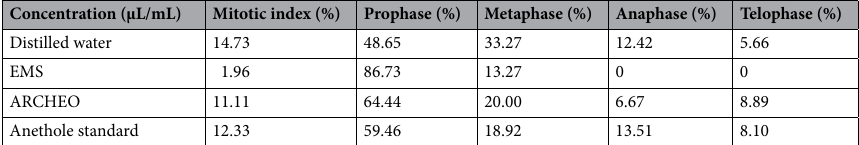
Table 7. Mitotic index and different stages of dividing cells in root tips of Allium cepa treated with ARCHEO , anethole (standard) and EMS. ARCHEO anethole rich C. heptaphylla essential oil, EMS ethyl